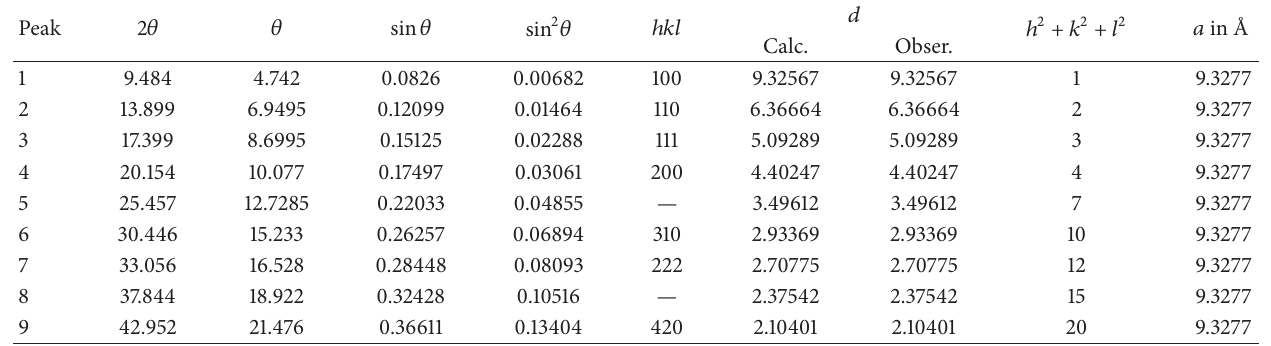
Table 6: Powder X-ray diffraction data of Cu(II) of the ligand HL.